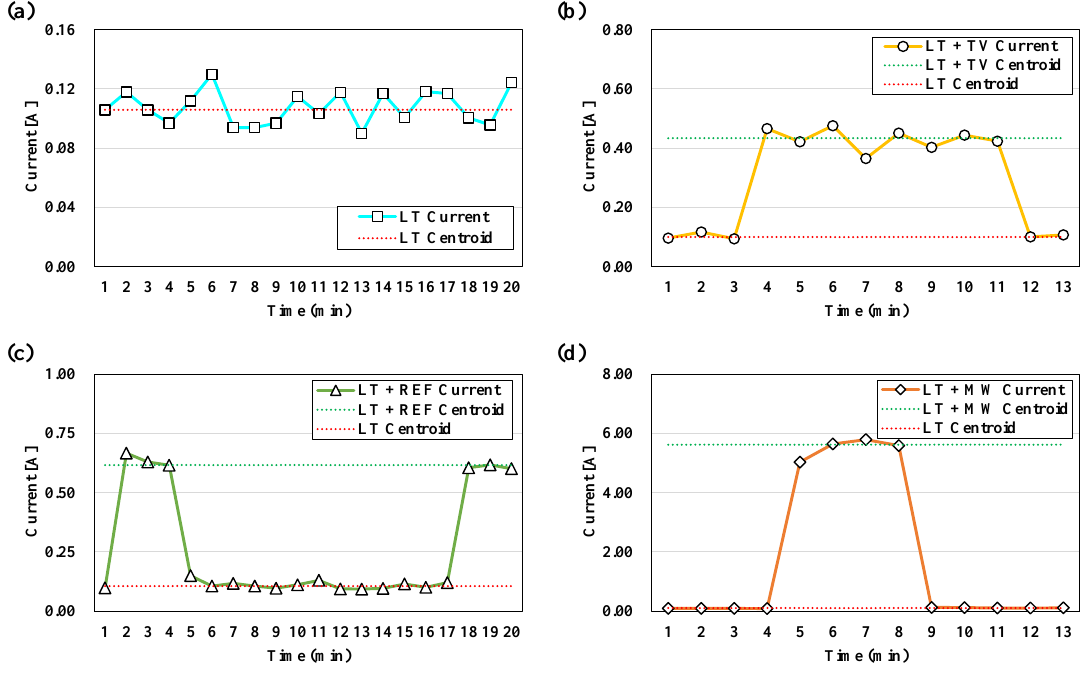
Figure 4. Measurement of usage patterns of appliances: ( a ) Laptop (LT); ( b ) Laptop + Television (LT + TV); ( c ) Laptop + Refrigerator (LT + REF); ( d ) Laptop + Microwave (LT + MW).